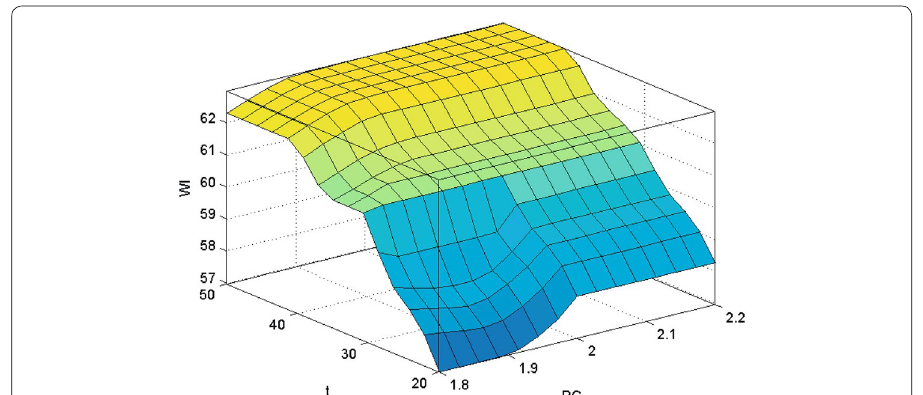
Fig. 9 Surface plot showing the effect of PC and t on WI